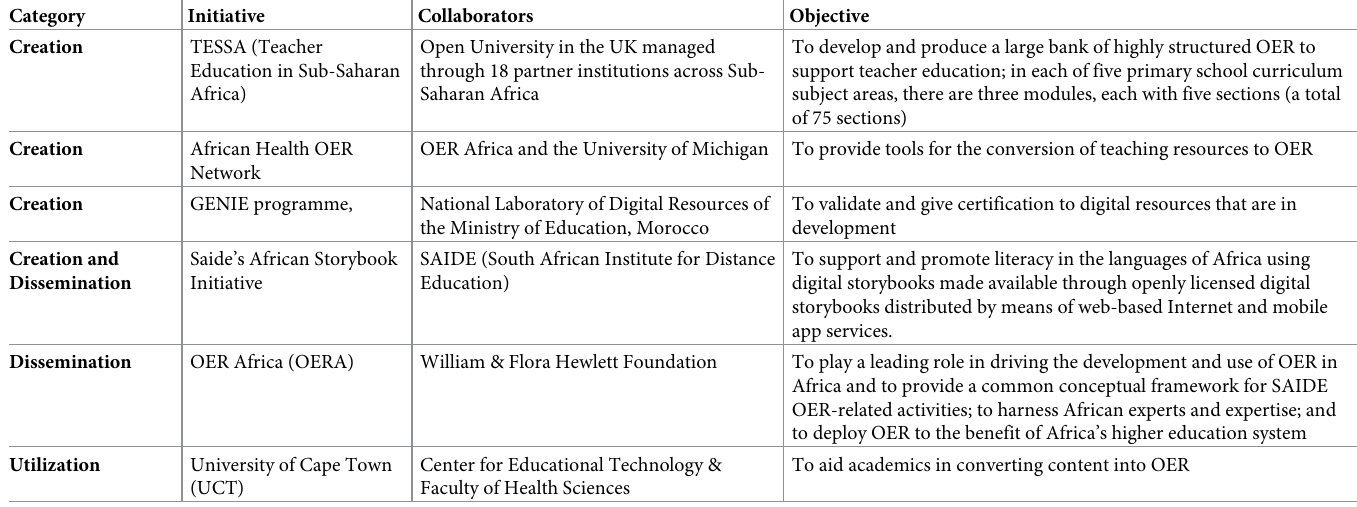
Table 3. Summary of OER initiatives in